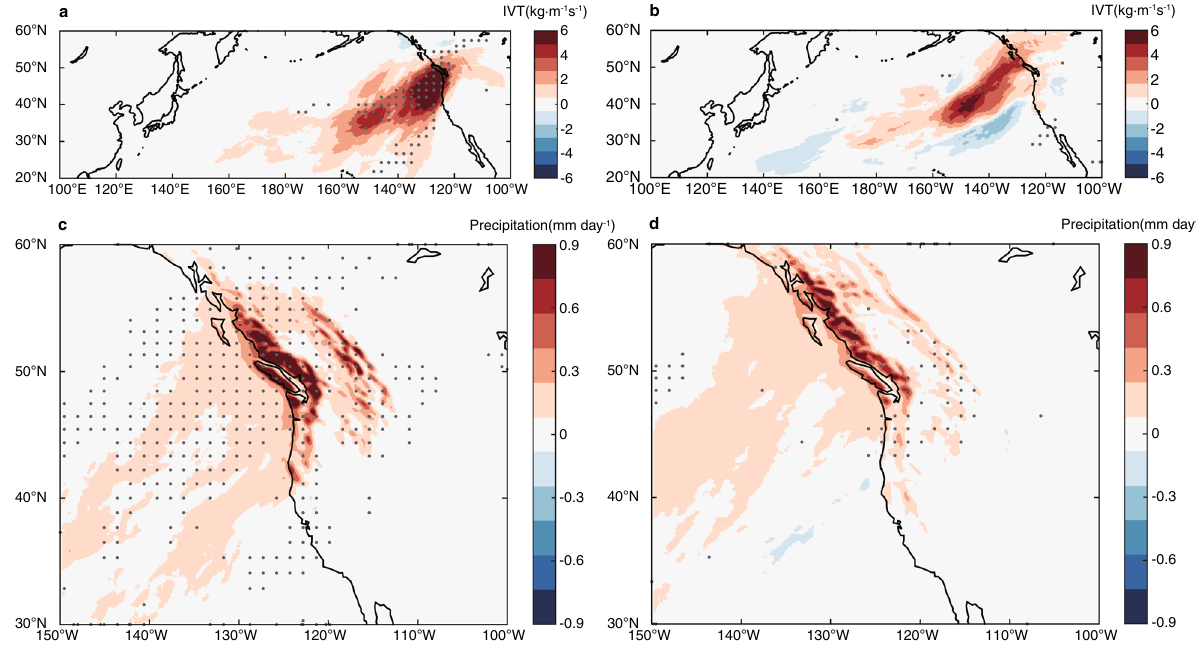
Fig. 3 Relationship between atmospheric rivers (ARs)/precipitation response strength and sea surface temperature forcing strength in the seasonal ensemble. a , c same as Fig. 2b, d, but for four strong mesoscale SST forcing cases. b , d , same as Fig. 2b, d, but for four weak mesoscale SST forcing